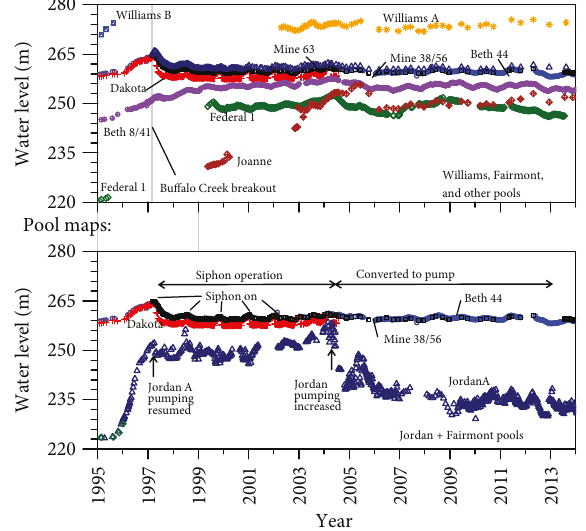
Figure 9: Water level hydrographs in (a) all pools and (b) Jordan and Fairmont pools, 1995 – 2014. Labels and symbols refer to water levels at individual monitoring wells within the speci fi ed mines (see Tables 1 and 2). Grey bars between plots refer to dates of fl ooding maps, Figure